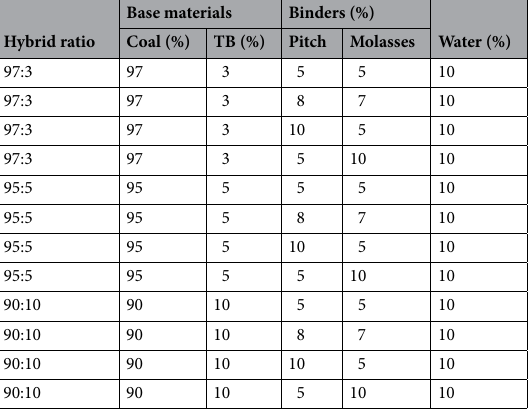
Table 1. Formulation of bio-coal briquettes using different blended binder